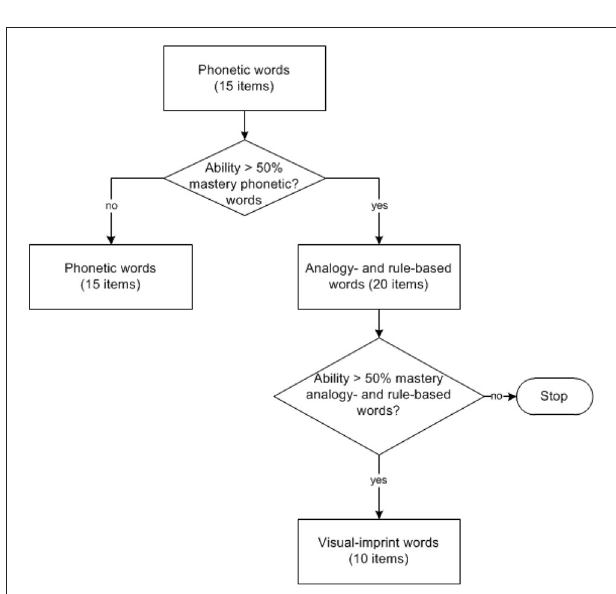
FIGURE 3 | Flow of the CAT spelling